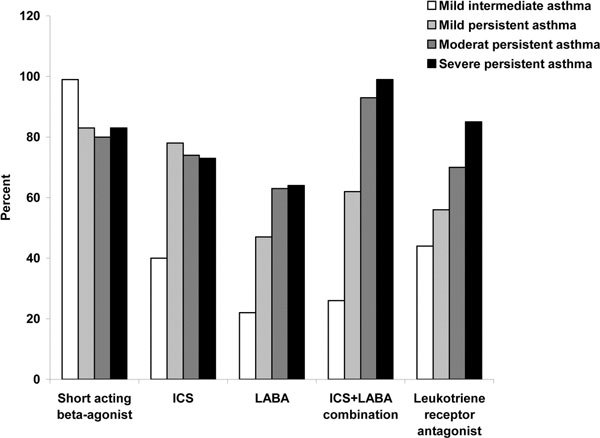
Asthma medications currently being prescribed by physicians as first-line therapy for differing severities of asthma. Physician question: Which medication or medications* do you prescribe as first-line treatment for: 1) mild intermittent asthma; 2) mild persistent asthma; 3) moderate persistent asthma; and 4) severe persistent asthma? *Physicians could provide more than one medication as a first-line treatment for each severity of asthma.